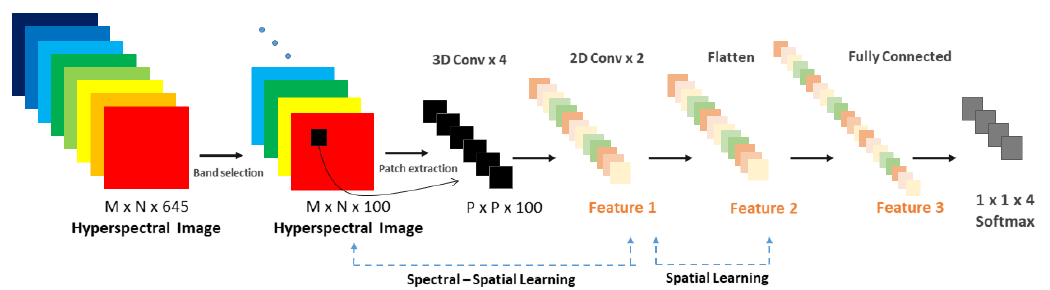
Figure 2. A 3D–2D hybrid Convolutional Neural Network (CNN) architecture for feature extraction and classification adapted from Roy et al. [30]. At the left, the band selection and patch extraction are shown. In the middle, the feature extraction by using 3D and 2D CNNs used for giving the final output depicted at the